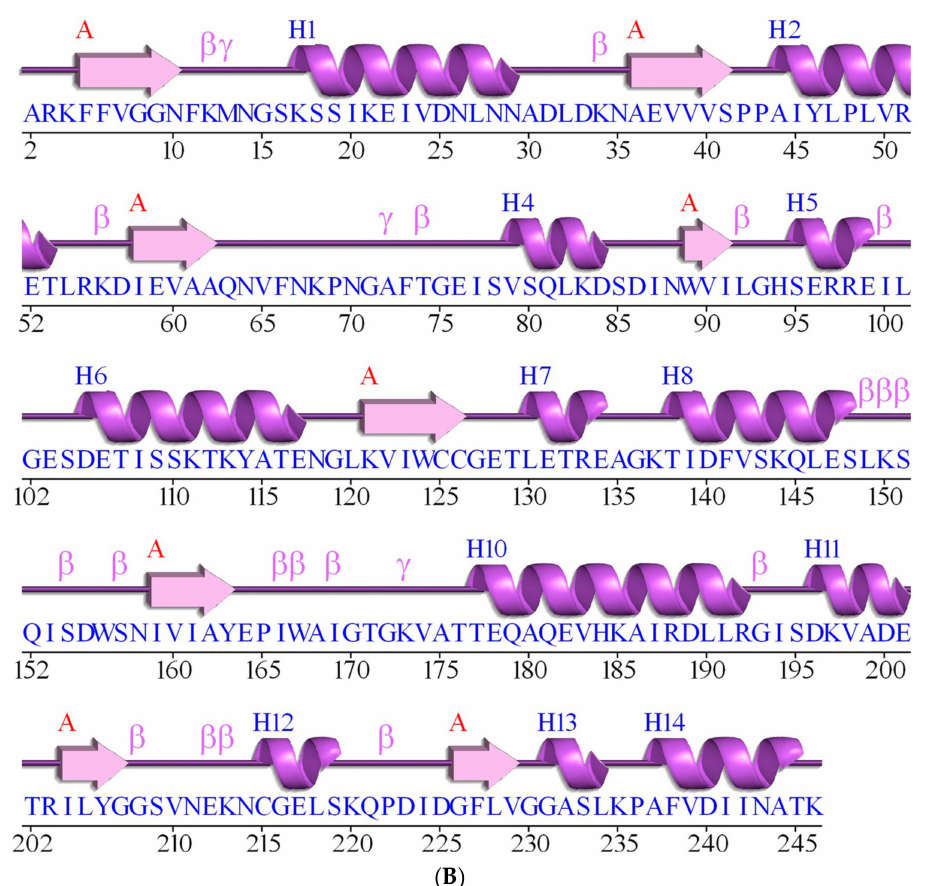
Figure 2. Bioinformatic analysis of FoxTPI with other triosephosphate isomerases (TPIs). (A) Sequence alignment of 21 TPIs and precition of secondary structure. The sequence alignment of TPIs from XP_018235652.1 ( Fusarium oxysporum f. sp. lycopersici 4287), 1TRE ( Escherichia coli ), 1M6J (